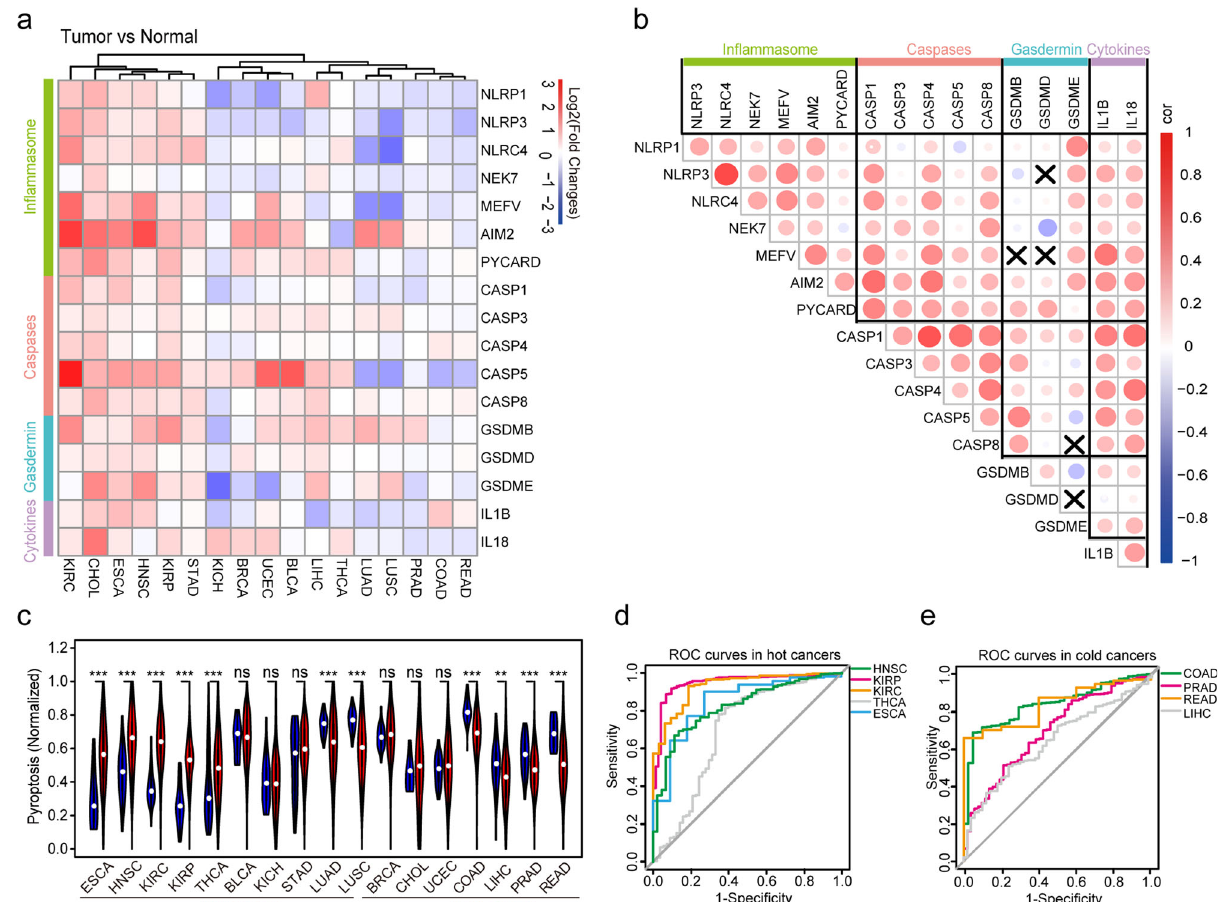
Fig. 1 The landscape of pyroptotic factors across 17 cancer types. a Heatmap of RNA expression alterations of the 17 pyroptosis-associated genes (PAGs) in 17 cancer types. RNA expression levels were calculated as log2 (average expression of the tumor to normal); b The correlation heatmap of the 17 PAGs in the 17 cancer types. X, P > 0.05; c The violin plots of the normalized enrichment score of the pyroptosis-associated genes (NESPAGs) for normal and tumor samples. The violin fi lling in red represents tumor samples, while that in blue represents normal tissue. d , e The receiver operating characteristic curve (ROC) curves for the prediction of normal and tumor